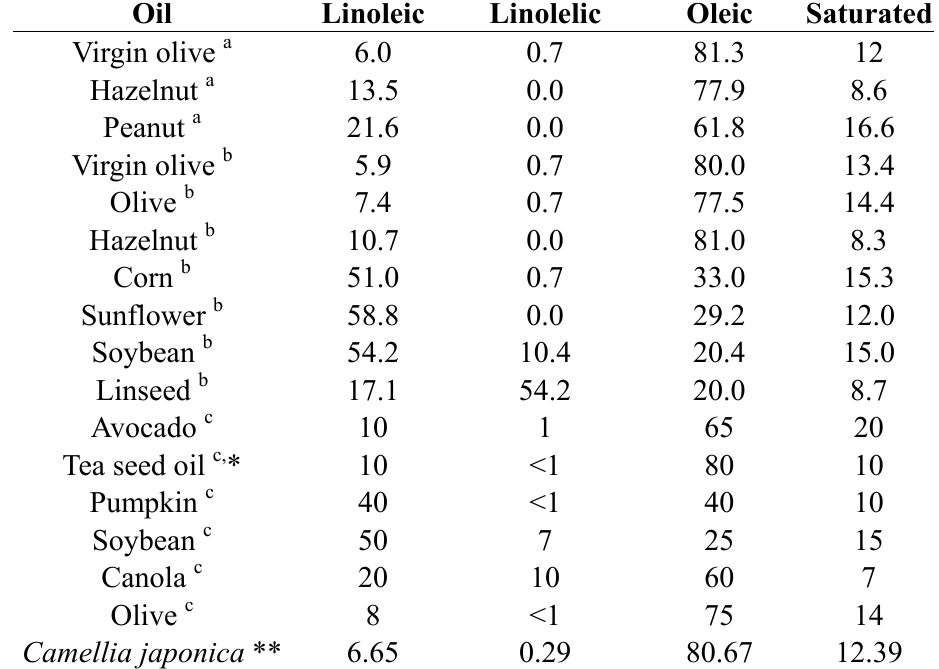
Table 3. Typical levels (in %) of C in common